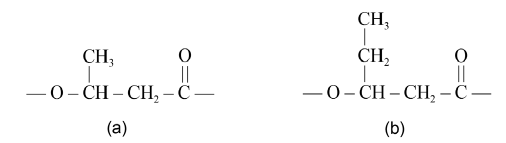
Figure 1. Structural units of 3-hydroxybutyrate 3HB (a) and 3-hydroxyvalerate 3HV (b). Commercial PHB´s used in the present work are random copolymers of 3HB and 3HV.